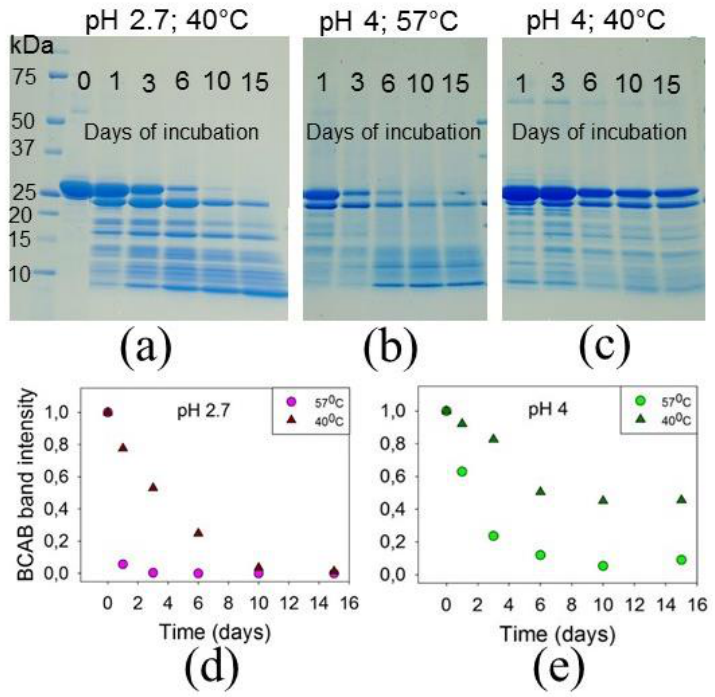
Figure 5. SDS-PAGE electrophoregrams of BCAB aliquots collected during incubation at pH 2.7 and 40 ◦ C ( a ); at pH 4 and 57 ◦ C ( b ); at pH 4 and 40 ◦ C ( c ). Changes in the full-length BCAB band intensity during incubation at pH 2.7 ( d ) and pH 4 (values are normalized relative to the total band intensity of the lane) ( e ).